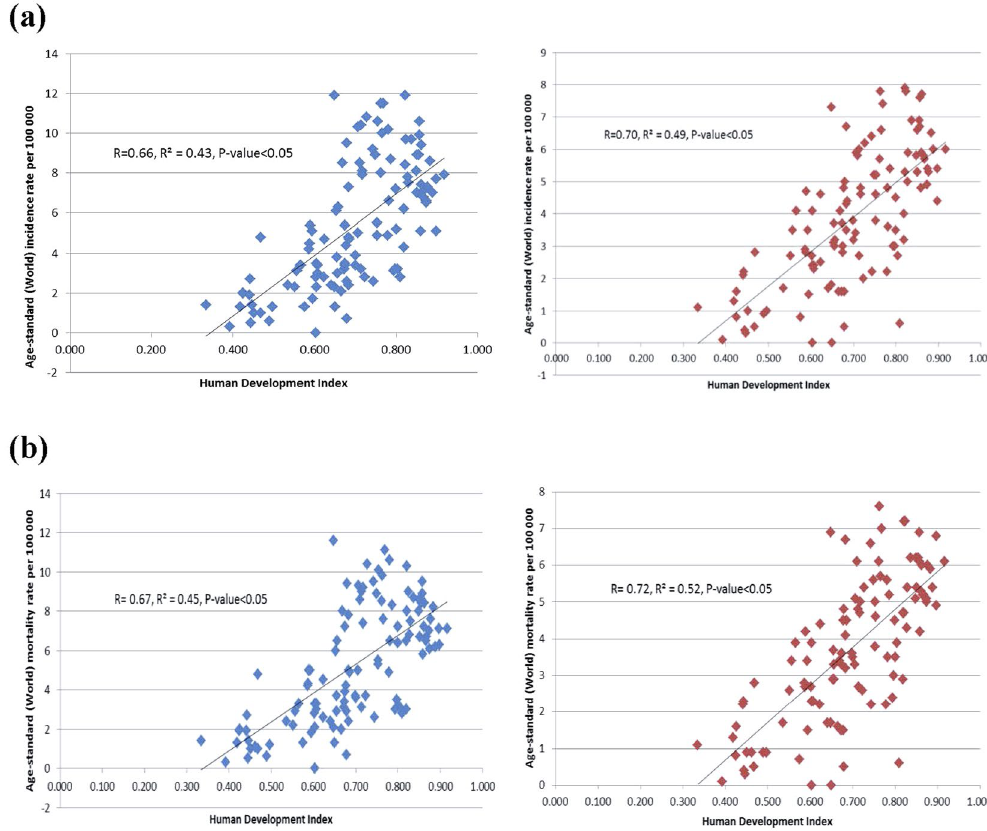
Figure 1. ( a ) Correlation between age-standardised incidence of pancreatic cancer in 2012 and Human Development Index (HDI) in 2000 in men (left) and women (right); ( b ). Correlation between age-standardised incidence of pancreatic cancer in 2012 and Gross Domestic Product (GDP) per capita in 2000 in men (left) and women